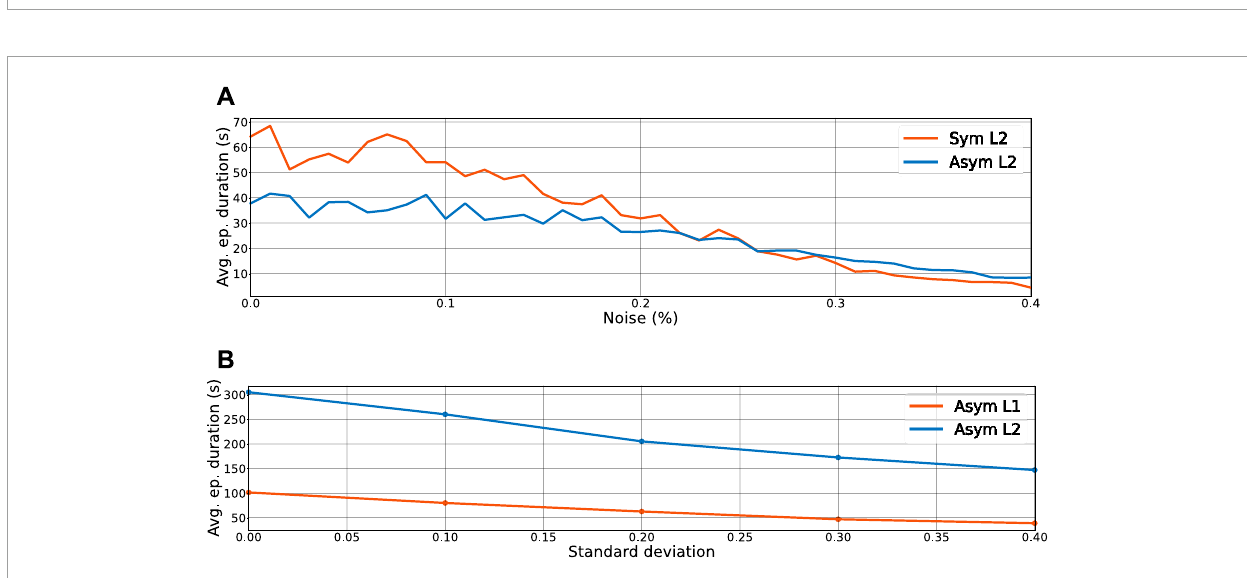
FIGURE 8 Robustness with regarding to the measurement noise and model uncertainties. (A) Average episode duration as a function of noise applied to the state observations for the symmetrical (orange line) and asymmetrical (blue line) policies learned and tested on the uneven terrain. (B) Average episode duration as a function of standard deviations of mass uncertainties applied to the masses from a normal distribution N ( 0 , σ ) .